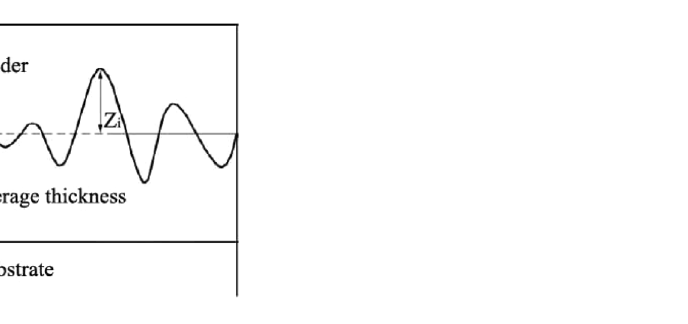
Figure 3. Schematic of Rrms at the solder joint